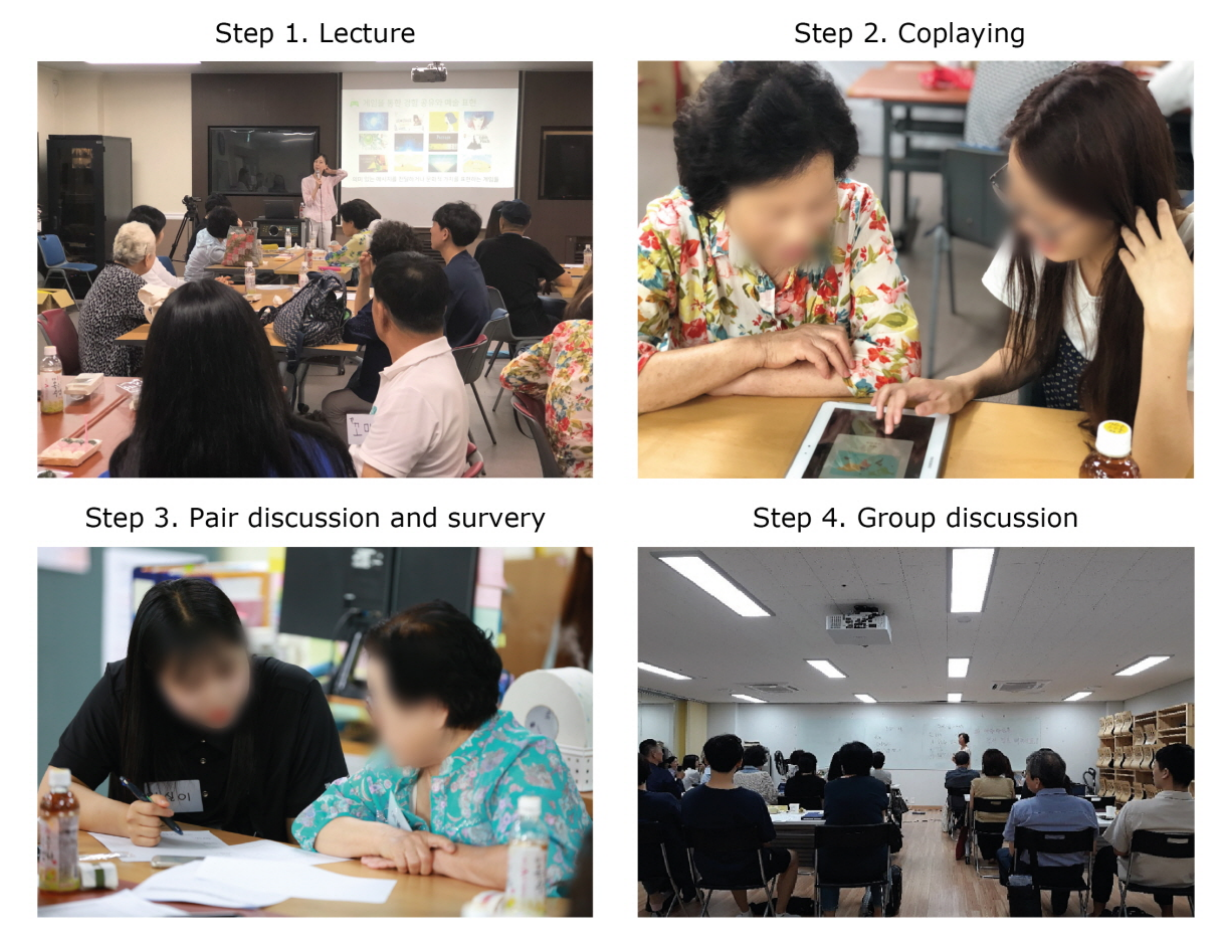
Figure 1. Photographs from the intergenerational play